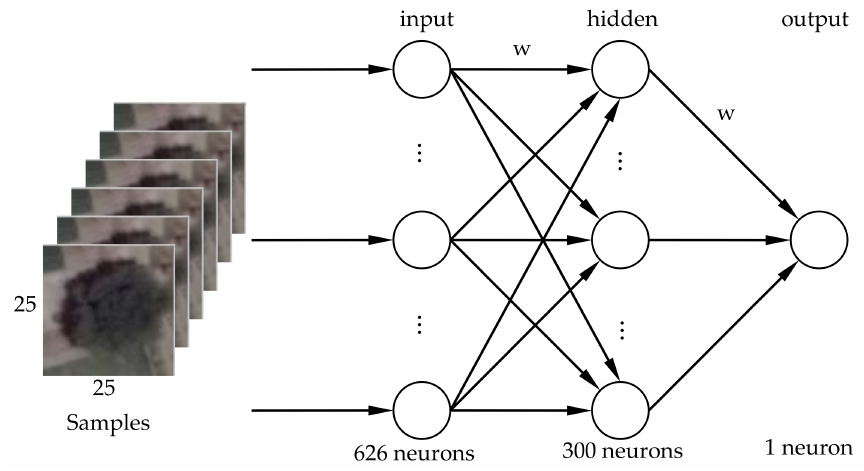
Figure 5. Structural design of a backpropagation (BP) neural